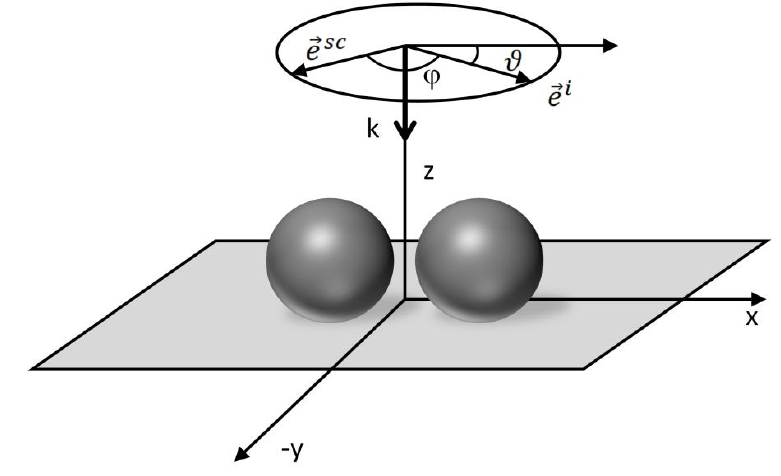
Figure 8. Geometry of a dimer. The Cartesian coordinate system is chosen so that the dimer axis lies in the 𝑥 direction, the excitation beam travells along the 𝑧 direction with the incident polarization making an angle 𝜗 with the 𝑥 axis. Scattered radiation is assumed to be collected in a backscattering geometry, allowing only the polarization making an angle 𝜑 with respect to the incident polarization (i.e., making an angle 𝜗 + 𝜑 with respect to the 𝑥 axis) to be detected.